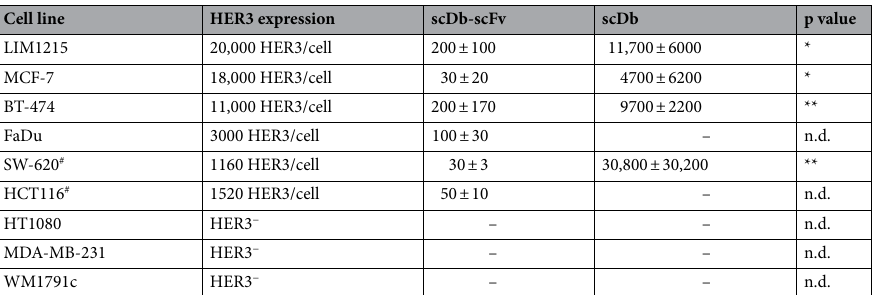
Table 1. Binding to HER3-expressing tumor cells of scDb and scDb-scFv. EC 50 [pM], Mean ± SD, n = 3. # For the HER3 low-expressing cell lines SW-620 and HCT116 the extrapolated values under the detection limit of 1900 molecules/cell (Qifikit) are depicted. *p < 0.05; **p < 0.01; n.s. p > 0.05; n.d., not